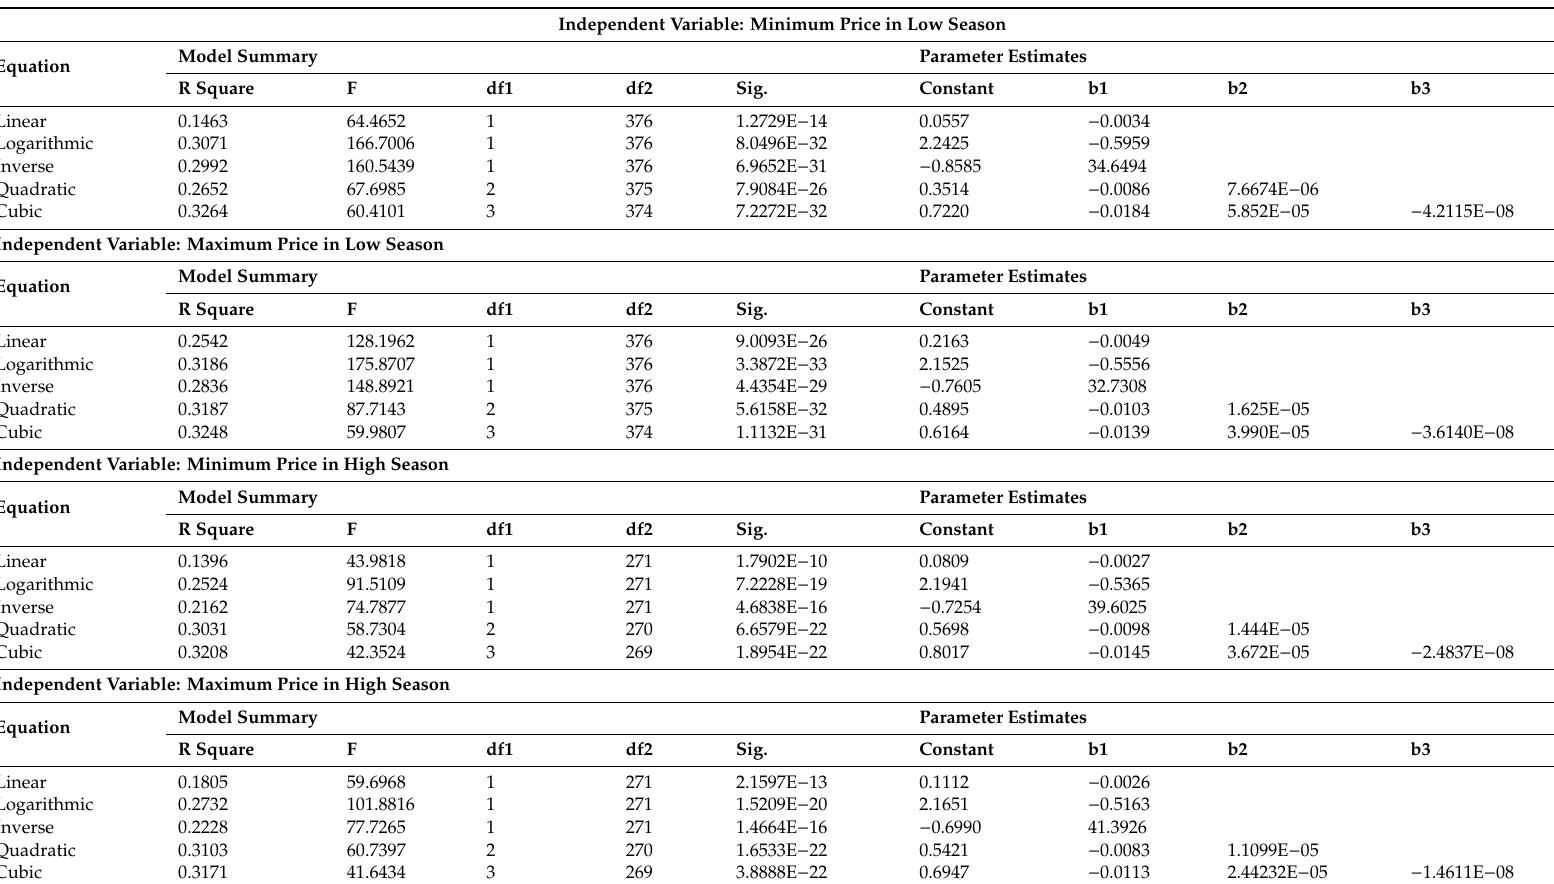
Table 4. Model summary and parameter estimates of regression analysis in all destinations with added value as dependent